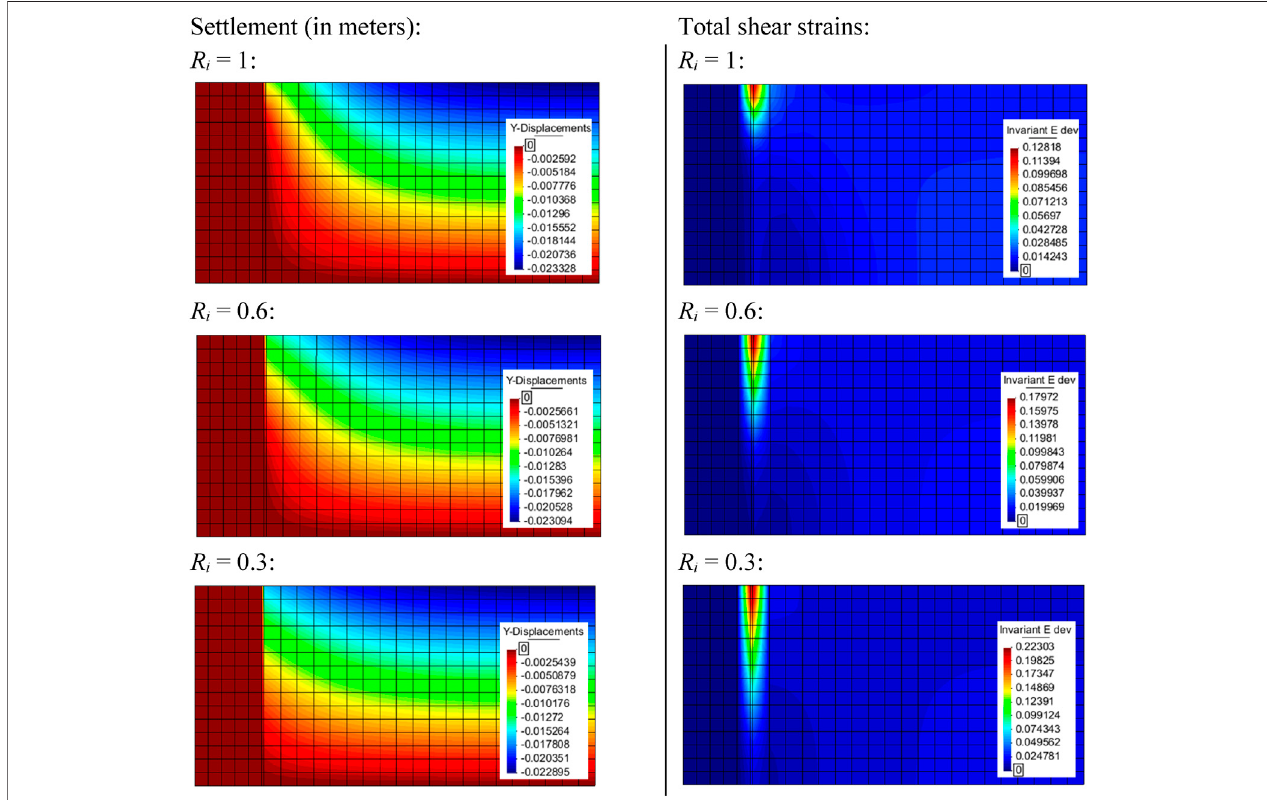
FIGURE 12 | Settlement and total shear strain evolution using program CODE_BRIGHT with q = 100-kPa surcharge and different strength/stiffness interaction factors.